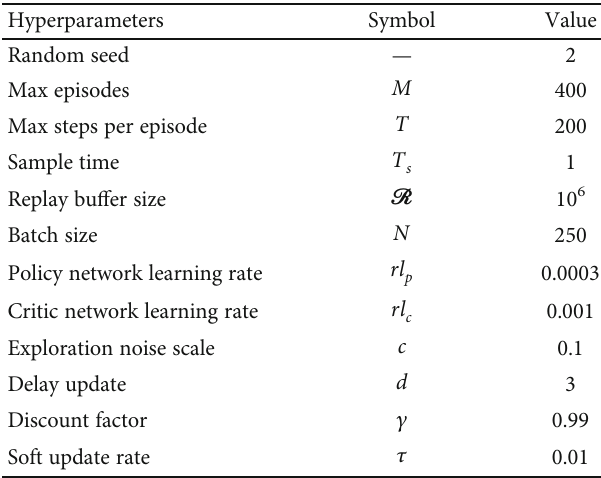
Table 2: Hyperparameter